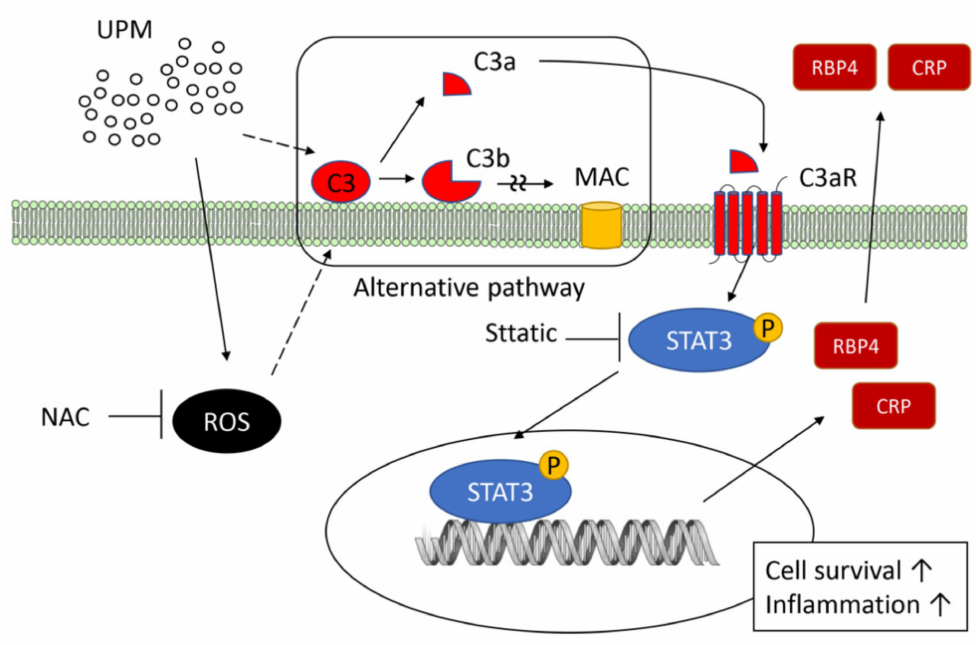
Figure 7. Schematic summary showing the activation of the complement system by UPM on human endothelial cells and its effects. UPM activates the complement system in human endothelial cells, in which ROS could be associated with complement activation. Dotted lines indicate unclear mechanisms in complement activation. C3a from complement activation induces the phosphorylation of STAT3, which increases cell proliferation and production of inflammatory